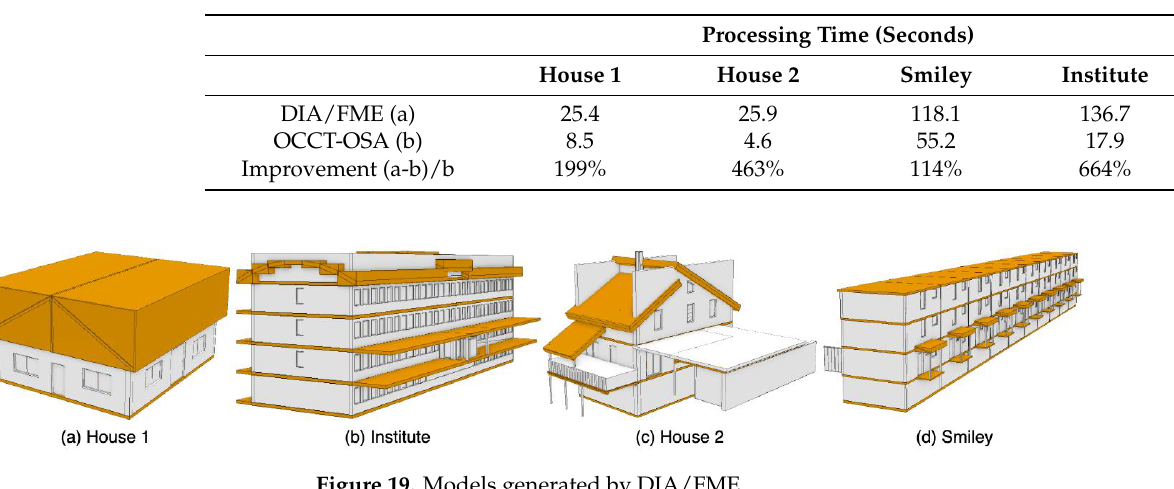
Table 11. Comparative summary for methods in IFC-to-shapefile conversion.